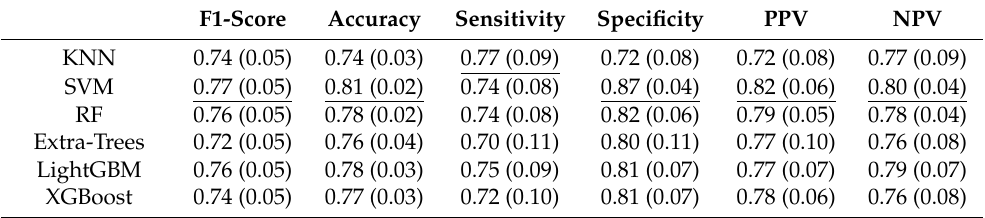
Table 9. Results of the predictive model. The underline means best score of each evaluation metrics. F1-Score Accuracy Sensitivity Specificity PPV NPV KNN